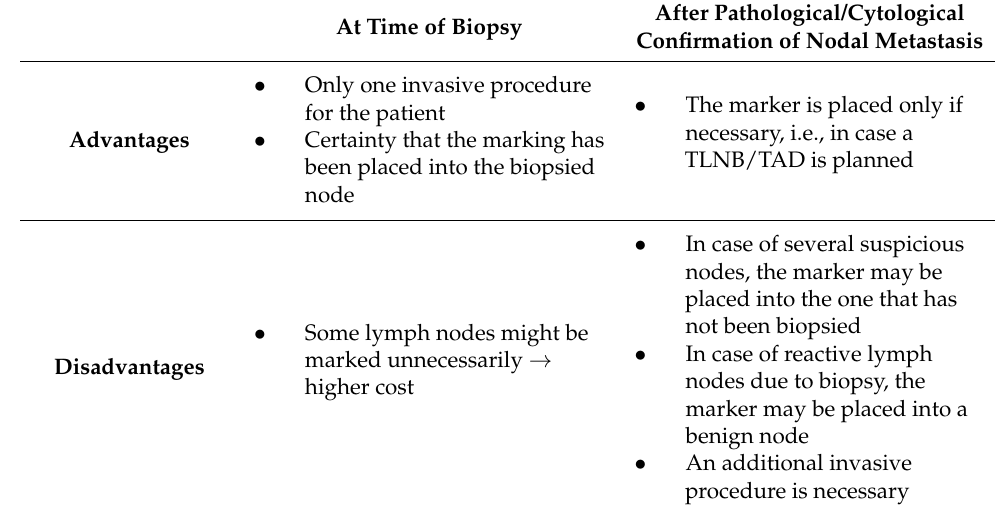
Table 7. Potential strategies regarding the time point of lymph node marking. After Pathological/Cytological At Time of Biopsy Confirmation of Nodal